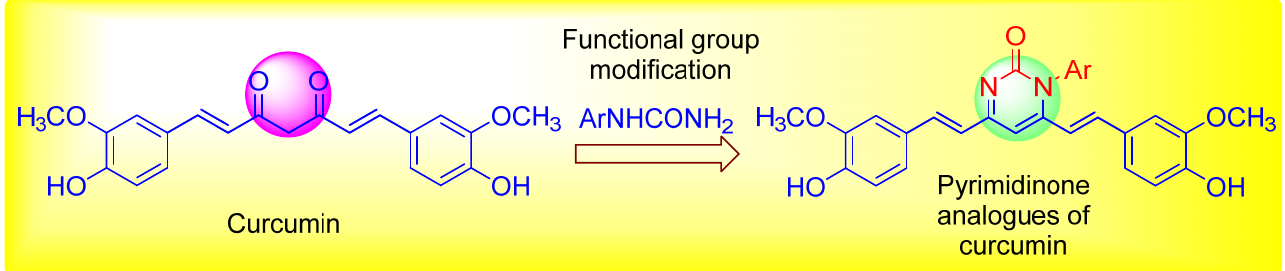
Figure 2. Structural modification of diketone function into pyrimidinone.